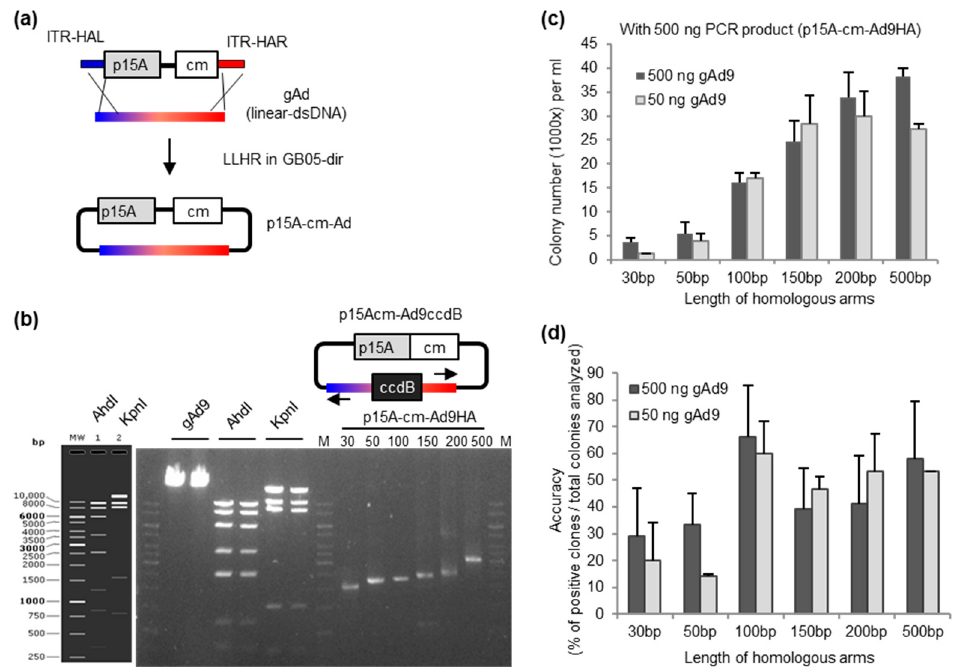
Figure 1. Homology arm-length dependence of adenoviral genome (gAd) cloning efficiency. ( a ) Schematic diagram illustrating the strategy for direct cloning of gAd isolated from cesium chloride (CsCl) purified adenovirus. The linear p15A-cm vector and adenoviral genome contain identical sequences at both ends (ITR-HAL and ITR-HAR) as homology arms (HA) for direct cloning. The gAds were cloned into the linear p15A-cm vector by linear-linear homologous recombination (LLHR) using the E. coli strain GB05-dir. ( b ) A polymerase chain reaction (PCR) product containing p15A and the chloramphenicol resistance gene (cm) flanked by adHAs was used for direct cloning. The plasmid p15Acm-Ad9ccdB was used as template to perform the PCR, generating a cloning vector with various HA length (30-, 50-, 100-, 150-, 200-, or 500-bp) (Figure S1). The gAd9 was digested either with AhdI or KpnI as verification. On the left panel is the simulated gel picture of the digest, while the actual digest is shown on the gel in the right panel. In the first two lanes are the isolated adenovirus type 9 genomes (gAd9). Then the digested gAd9 and PCR products are depicted. M, 1 Kb DNA marker (VWR, Langenfeld, Germany). Five hundred nanograms of the PCR-generated linear vector flanked by 30-, 50-, 100-, 150-, 200-, or 500-bp homology arms was co-transformed with either 50 ng or 500 ng of gAd9 into the E. coli strain GB05-dir. The cloning e ffi ciency is expressed via colony number